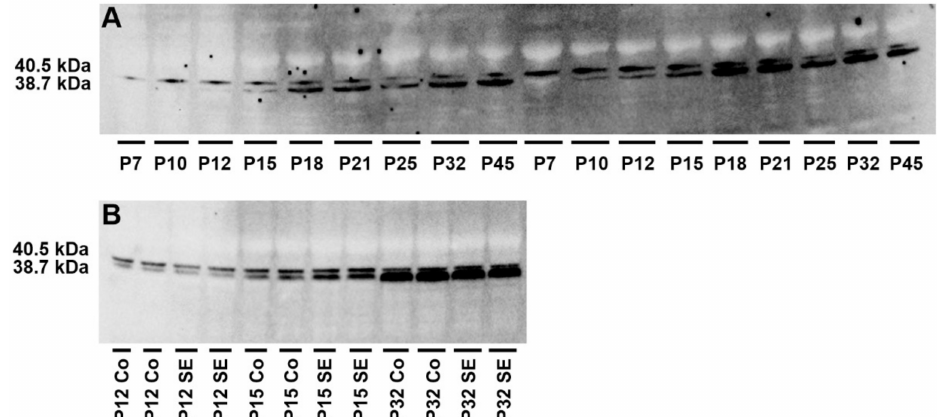
Figure 7. Western blotting of hippocampal homogenates showing the density of ADK isoforms–ADK- S (38.7 kDa) and ADK-L (40.5 kDa) during brain development in control rats ( A ) and corresponding age-matched LiCl/pilocarpine SE rats ( B ). ( A ) Abscissae from left to right: 7, 10, 12, 15, 18, 21, 25, 32, and 45-day-old rats in identical replicates. ( B ) Abscissae from left to right: 12-, 15-, and 32-day-old rats in identical